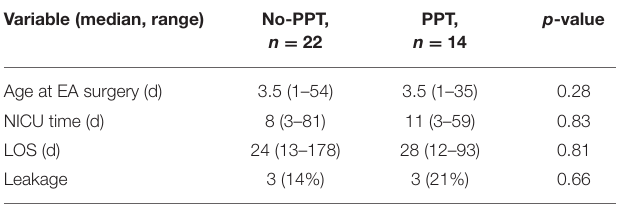
TABLE 3B | Surgical data of group 2 (2017–2019).